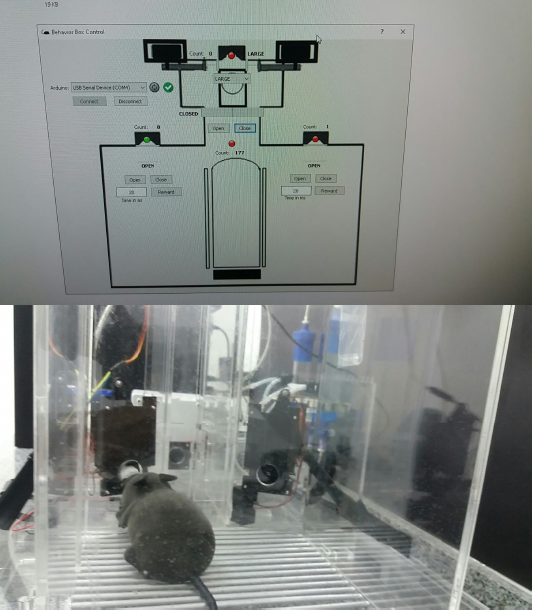
Figure 21. Remote control mouse in behavior box: activating the left reward sensor, referring to the wide position of the